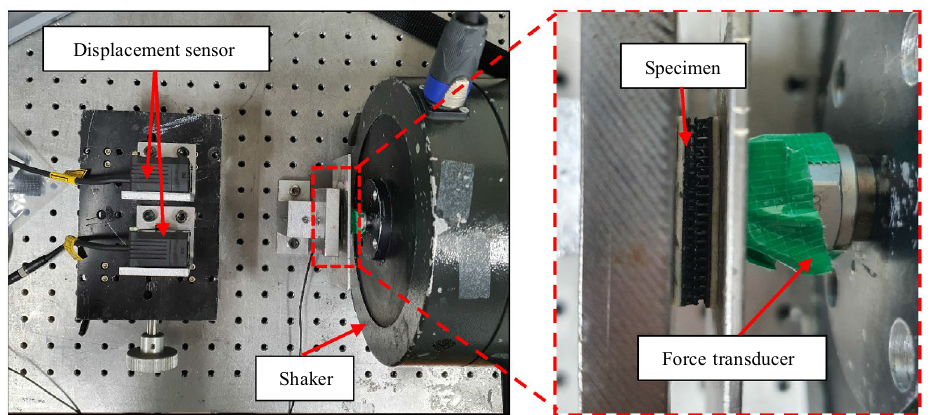
Figure 3. Uniaxial tension and compression test setup to measure the hysteresis loops of the polymer materials and the probabilistic